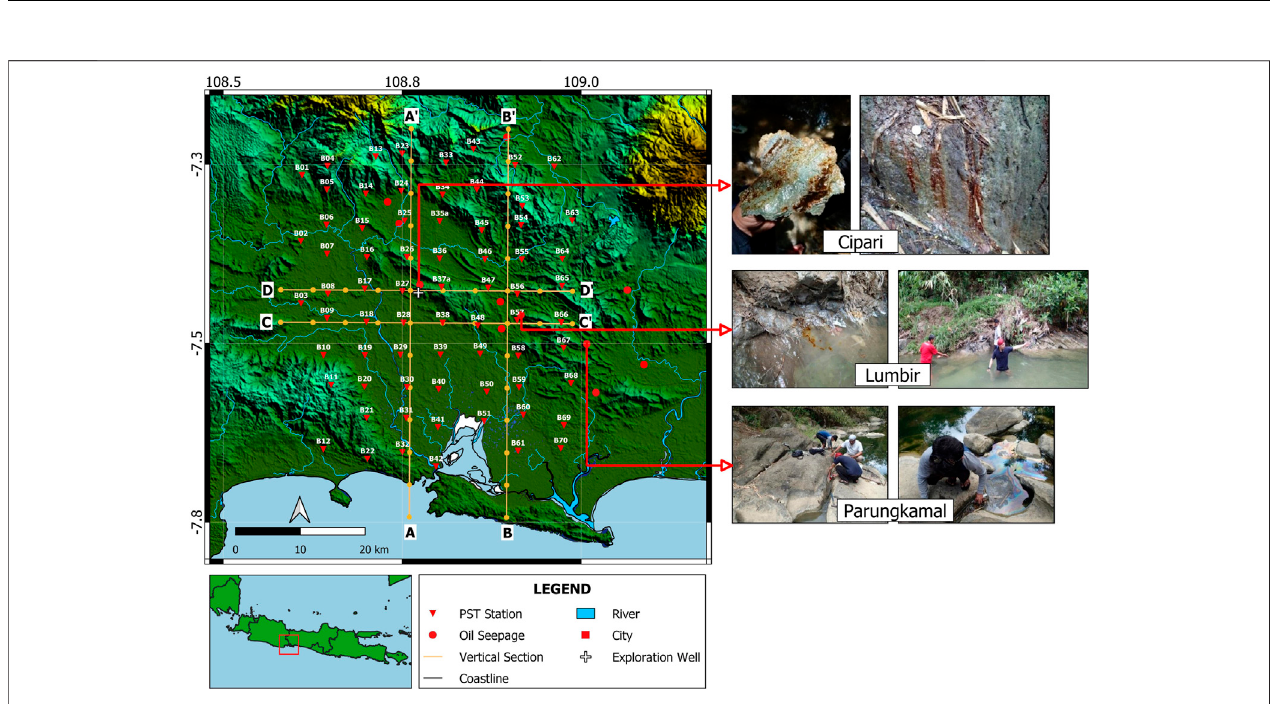
FIGURE9| OverlayofoilseepagedatadistributionandJati-1explorationwelltotheverticalsectionoftheVp,Vs,andVp/Vsratiobasedontraveltimetomography inversion results around the PST network (modi fi ed from Junursyah et al., 2019).